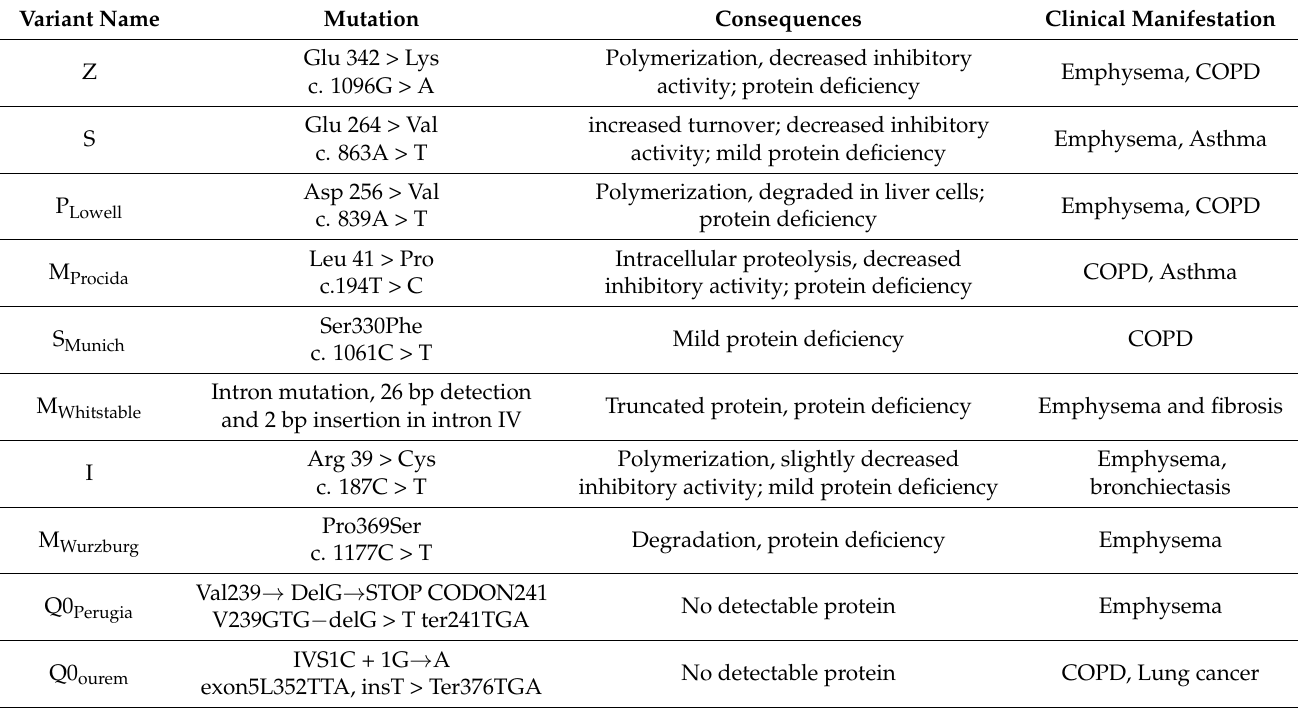
Table 2. The M allele is the most common, and homozygosity (MM) is associated with normal alpha1-antitrypsin levels. The S, Z, and rare alleles are associated with varying degrees of AAT deficiency. The AAT variants are indicated with the corresponding mutation, the consequent anomaly, and the clinical data detected in our